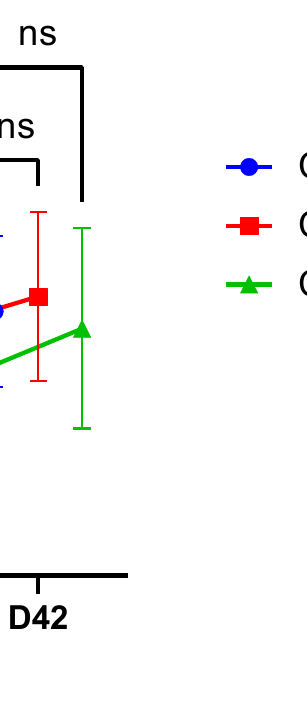
Figure 4. ELISA detection of porcine anti-cCPS antibodies (IgM). Total IgM levels against cCPS in pig serum. ELISA plates were coated with S. suis serotype 2 capsular polysaccharide and incubated with pig serum (dilution 1:100). IgM levels were measured for CPS-OVA, CPS-CRM197 and control (not vaccinated) groups (n = 10 each) on the day of vaccination (D0), the day of revaccination (D21), the day of infection (D35) and at the end of the experiment (D42) at 450 nm. The CPS-OVA group induced significantly higher antigen-specific IgM response (*, p ≤ 0.05) than the control group on D21 and D35.